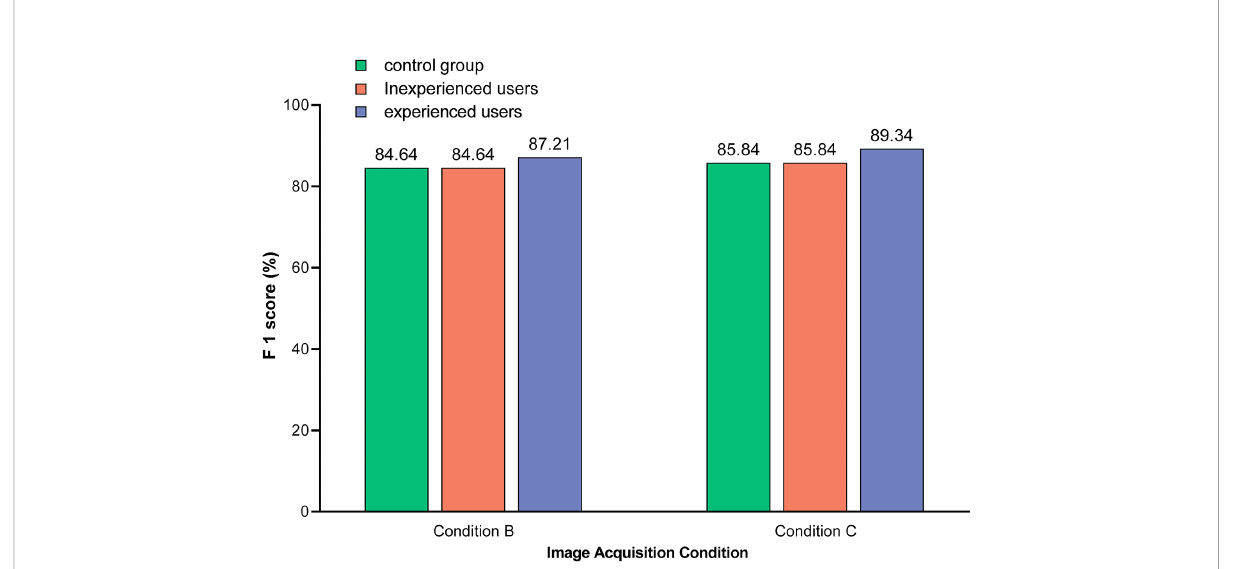
FIGURE 7 Comparison of the model identi fi cation F1-scores between different users. Images used in control group included test sets 4 and 7, which were acquired under condition B and C, respectively, and covered 12 subcategories of symptoms (S1 – S12). Images used in unexperienced users included test sets 5 and 8, which were acquired under condition B and C, respectively, and covered all 14 subcategories of symptoms (S1 – S14). Images used by experienced users included test sets 6 and 9, which were acquired under condition B and C, respectively, and covered seven subcategories of symptoms (S3 – S9). Note: The value on the bar indicates the exact